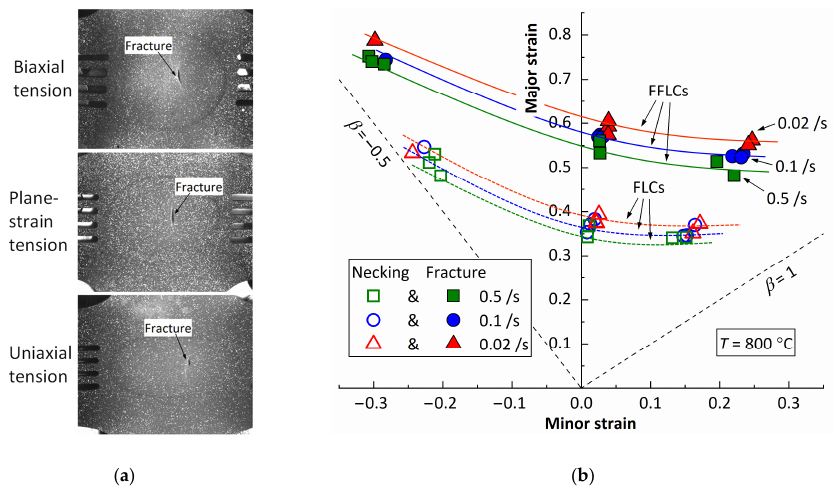
Figure 8. FLCs and FFLCs for boron steel determined using the novel biaxial test method [7]: ( a ) damaged cruciform specimens at 800 °C and 0.1 /s in different strain states and ( b ) FLCs and FFLCs determined for boron steel at a strain rate of 0.1 /s and different temperatures.